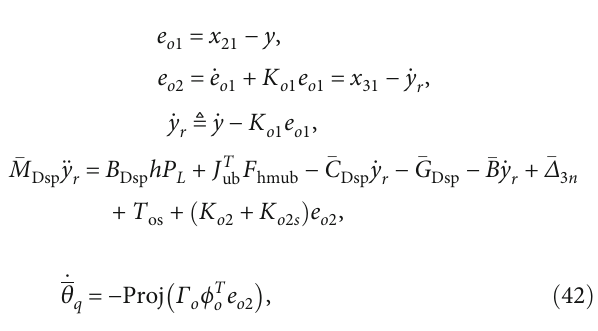
ð x Þ B θ . = Y 31 31 B